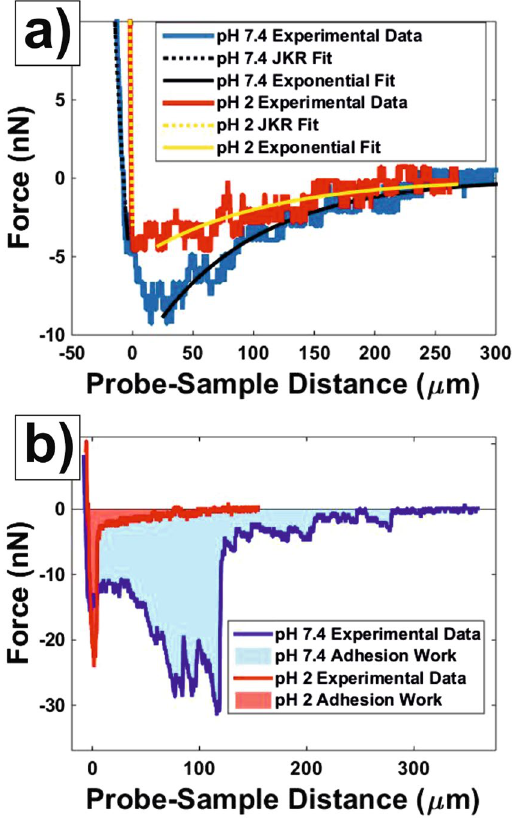
Figure 4. Representative force measurements on ileum mucosa at different pH values. ( a) Approach force measurements obtained in PBS pH 7.4 (blue) and pH 2 (red). Fits of the contact region to the JKR model (Eq. 3) and of the non-contact region to an exponential function (Eq. 8) are also shown. ( b) Withdrawal force measurements obtained in PBS pH 7.4 (blue) and pH 2 (red). The shaded area below the adhesion peaks corresponds to the work of